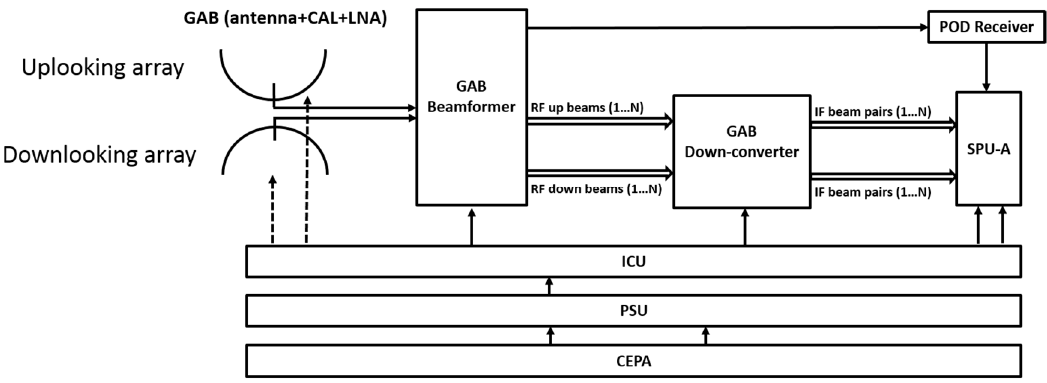
Figure 2. GEROS-ISS payload high level block diagram. Acronyms: GAB: GEROS Antenna Beamformer, ICU: Instrument Control Unit; PSU: Power Supply Unit; CEPA: Columbus External Payload Adapter; and SPU: Signal Processing Unit (SPU B removed during one of the Phase A studies).